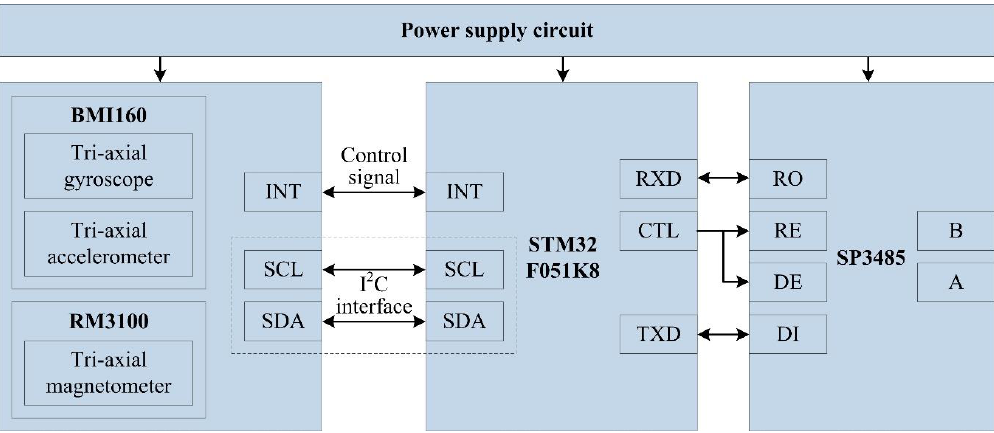
Figure 4. Composition of the attitude measurement unit.